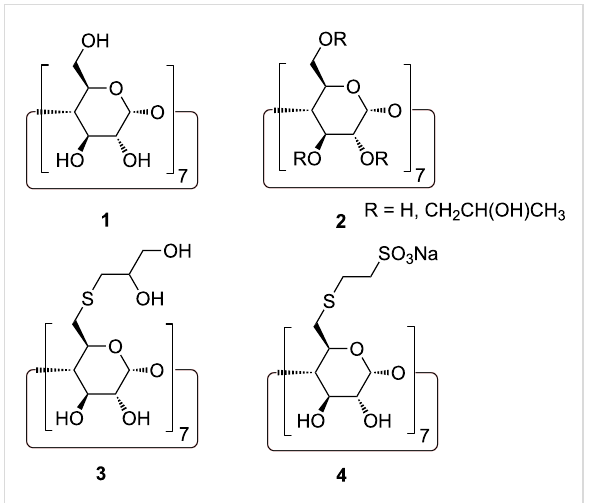
Figure 2: Chemical structures of the benzene and cyclohexane deriva- tives, with their calculated molecular volumes, V G = M / dN A in Å 3 , with M molecular weight, d density, N A Avogadro’s